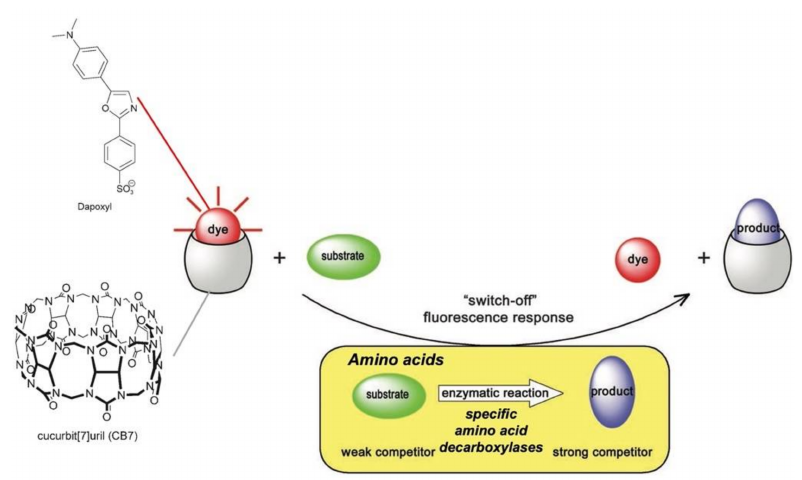
Figure 10. Schematic representation of the working principle of the IDA assay based on the CB7@Dapoxyl reporter pair developed by Nau and coworkers. Adapted from Ref. [43] Wiley, copyright